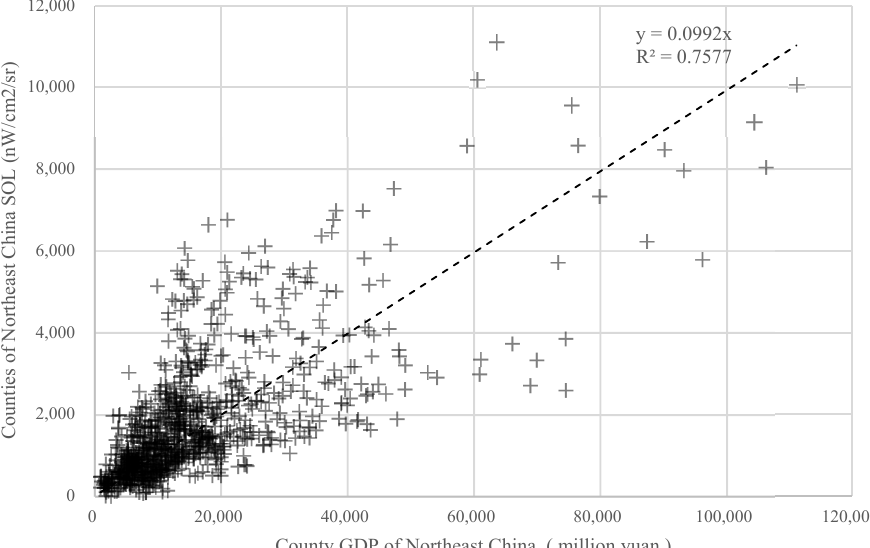
Figure 2. The fitting diagram of county GDP and county SOL in Northeast China from 2012 to 2020.